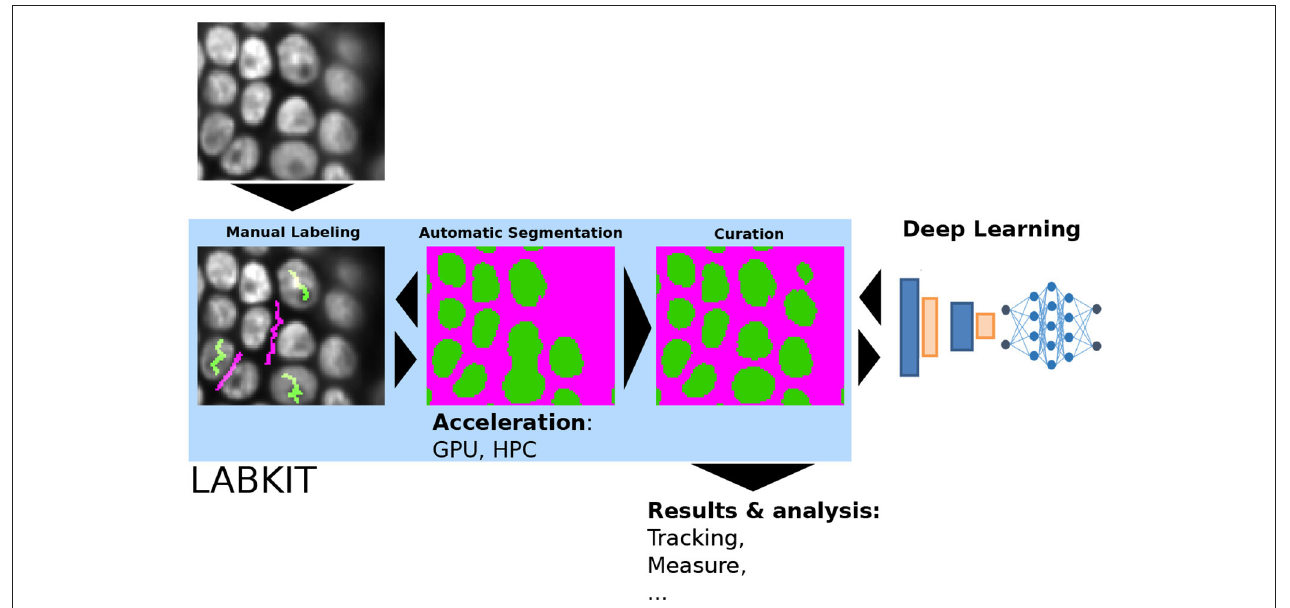
FIGURE 6 | LABKIT ’s iterative and interactive segmentation used for ground-truth generation: manual labeling, automatic segmentation and curation in LABKIT enable easy and rapid image segmentation, whose results can be further processed or used as ground-truth for deep-learning